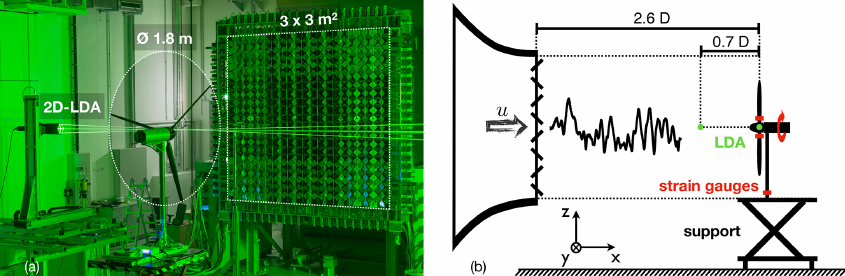
Figure 1. (a) Picture of MoWiTO 1.8 and 2D-LDA in a wind tunnel with active grid. Note the visible shift of grid flap angles between the centred inner square and outer compensating axes, demonstrated in the picture for a smaller inner square part than used in the investigation. (b) Schematic of setup with coordinate system in the wind